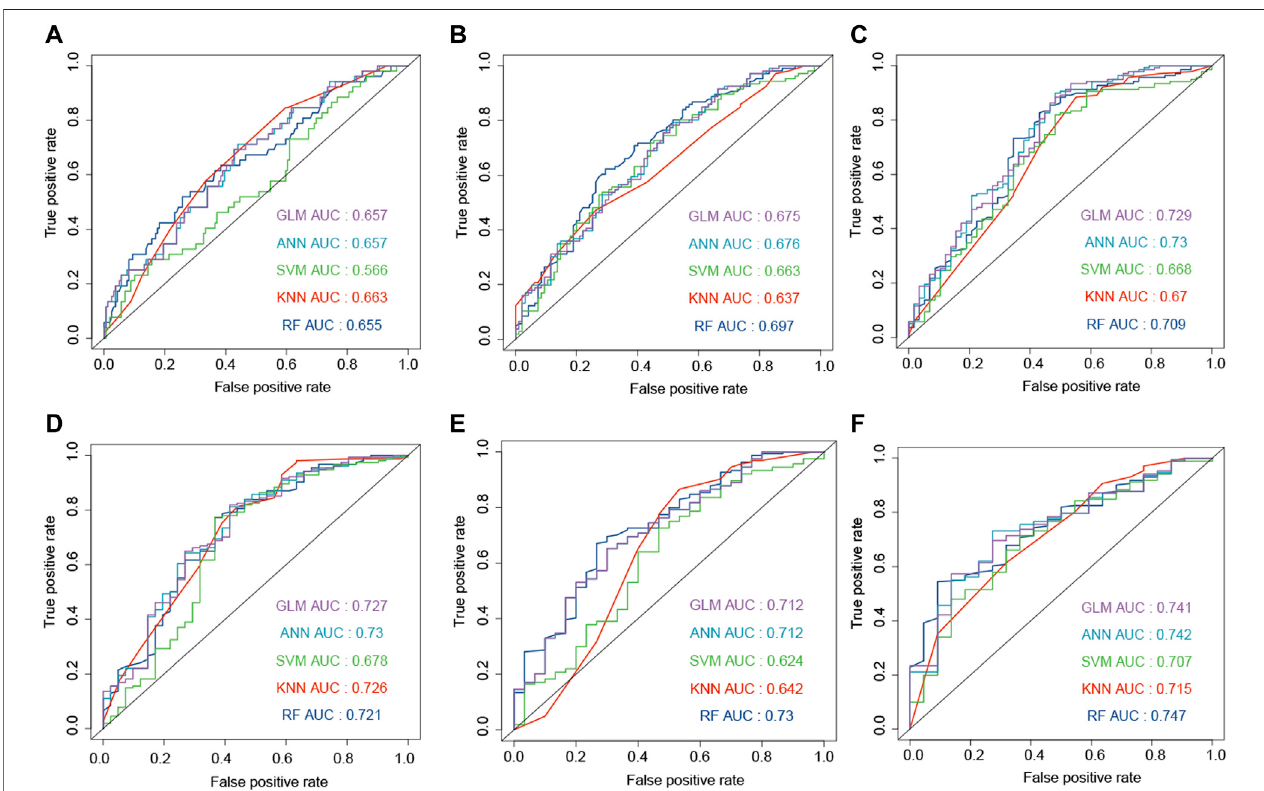
FIGURE5 | Development ofthe machine learning models to predict the survival status at 6 (A) , 12 (B) , 18 (C) , 24 (D) , 30 (E) , and 36 (F) months based on gender, age, and ECM genes (AEBP1, F3, FLNC, IGFBP2, and LDHA). The models were trained on the training dataset, and these AUC results were calculated on the testing